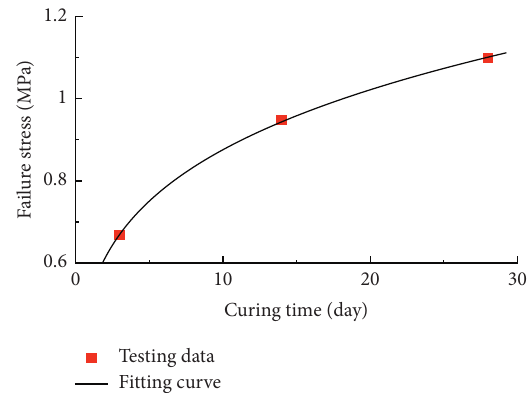
Figure 17: The failure stress for stabilized soils with different curing times (confining pressure � 0.1 MPa; stabilizer content �